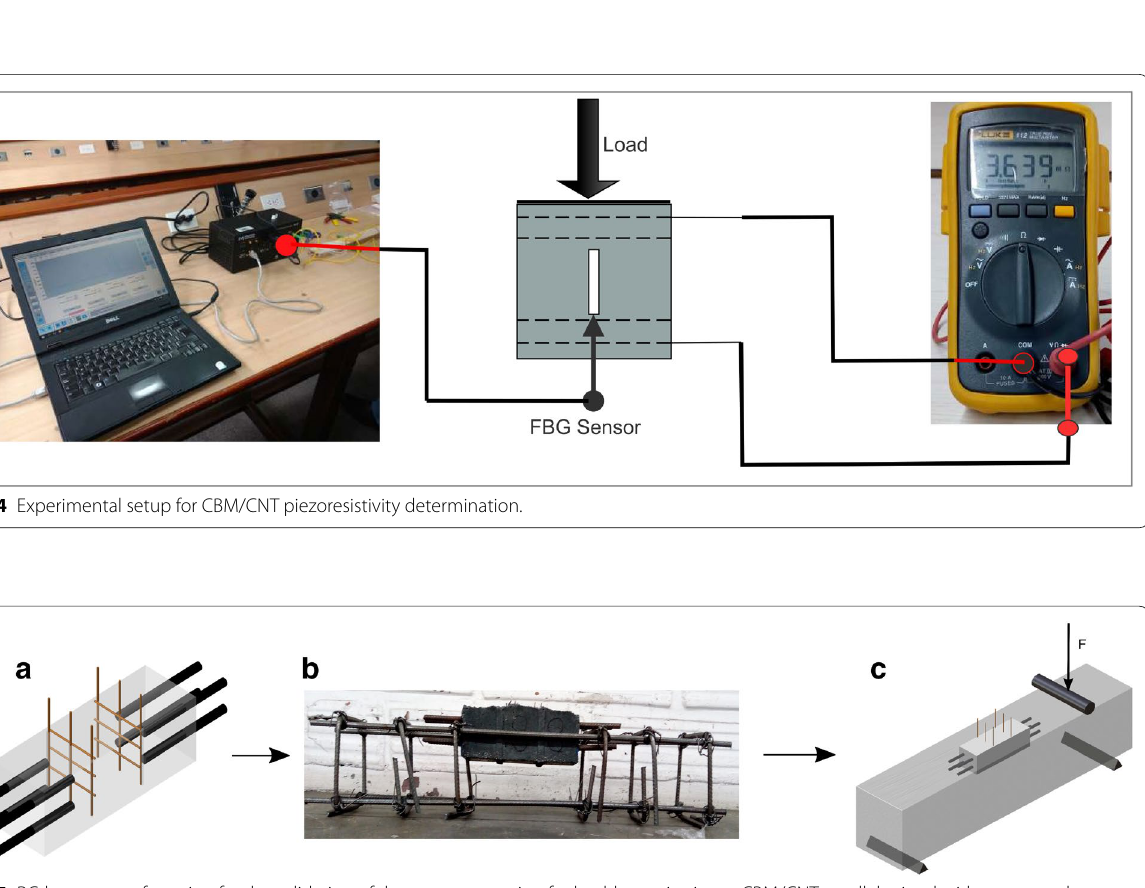
Fig. 5 RC‑beam manufacturing for the validation of the sensor operation for health monitoring. a CBM/CNT parallelepiped with corrugated steel rods. b Inclusion of the CNC/CBM parallelepiped within the steel frame of the RC beam. c Casting over the CNC/CBM parallelepiped and the reinforced steel structure of the concrete for the fabrication of the RC